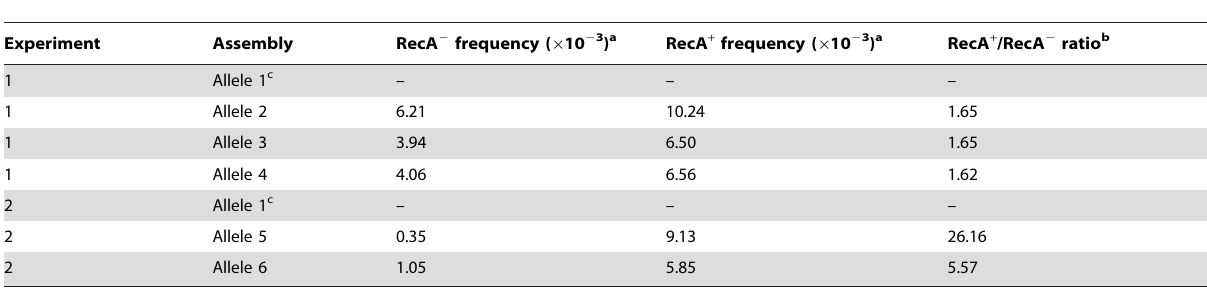
Table 7. Variation in the opaK gene of N. gonorrhoeae strain FA1090.